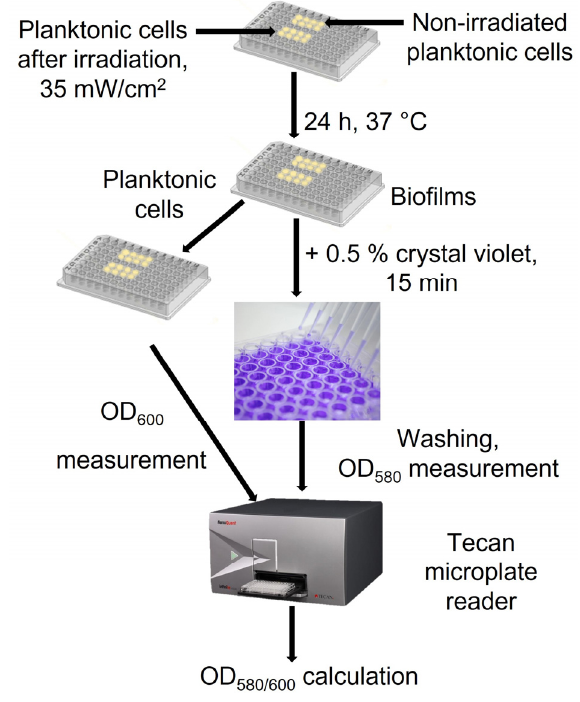
Figure 8. Scheme of A. baumannii biofilm formation assay after aPDT.